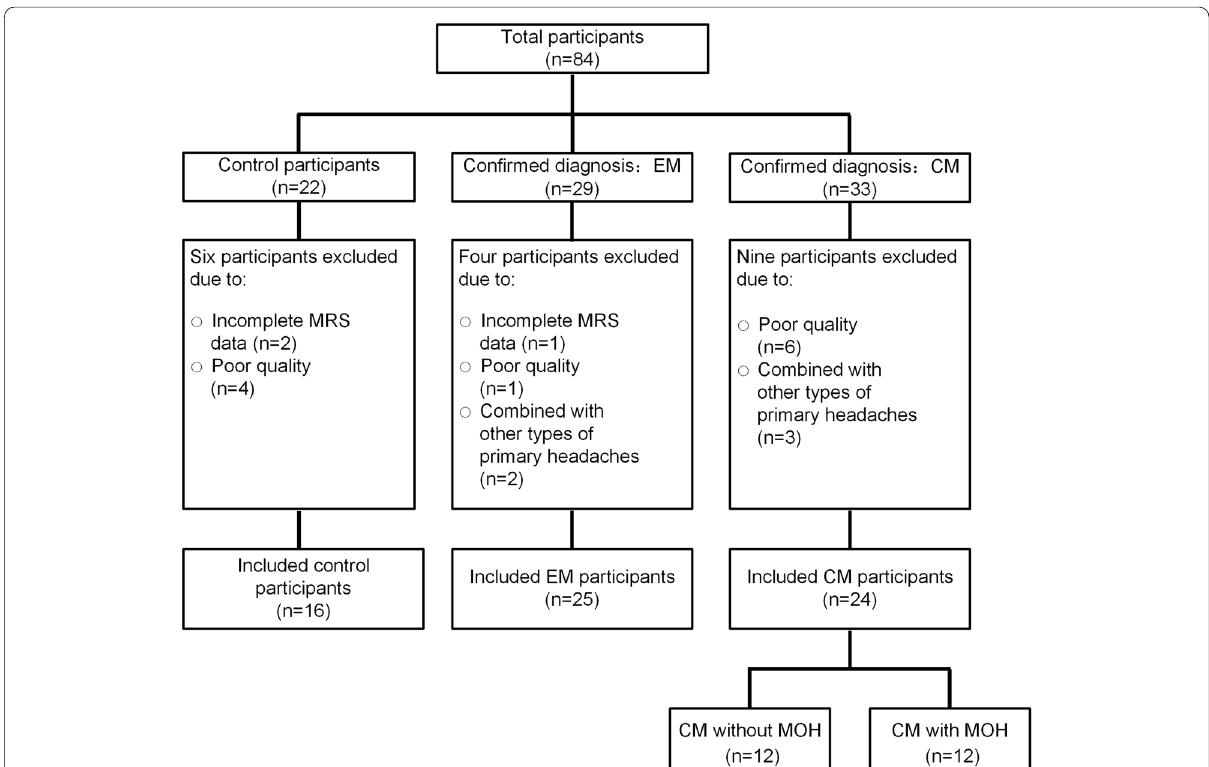
Fig. 2 Flow of the participants during the study. Abbreviations: CM, chronic migraine; EM, episodic migraine; MOH, medication overuse headache; MRS, magnetic resonance spectroscopy